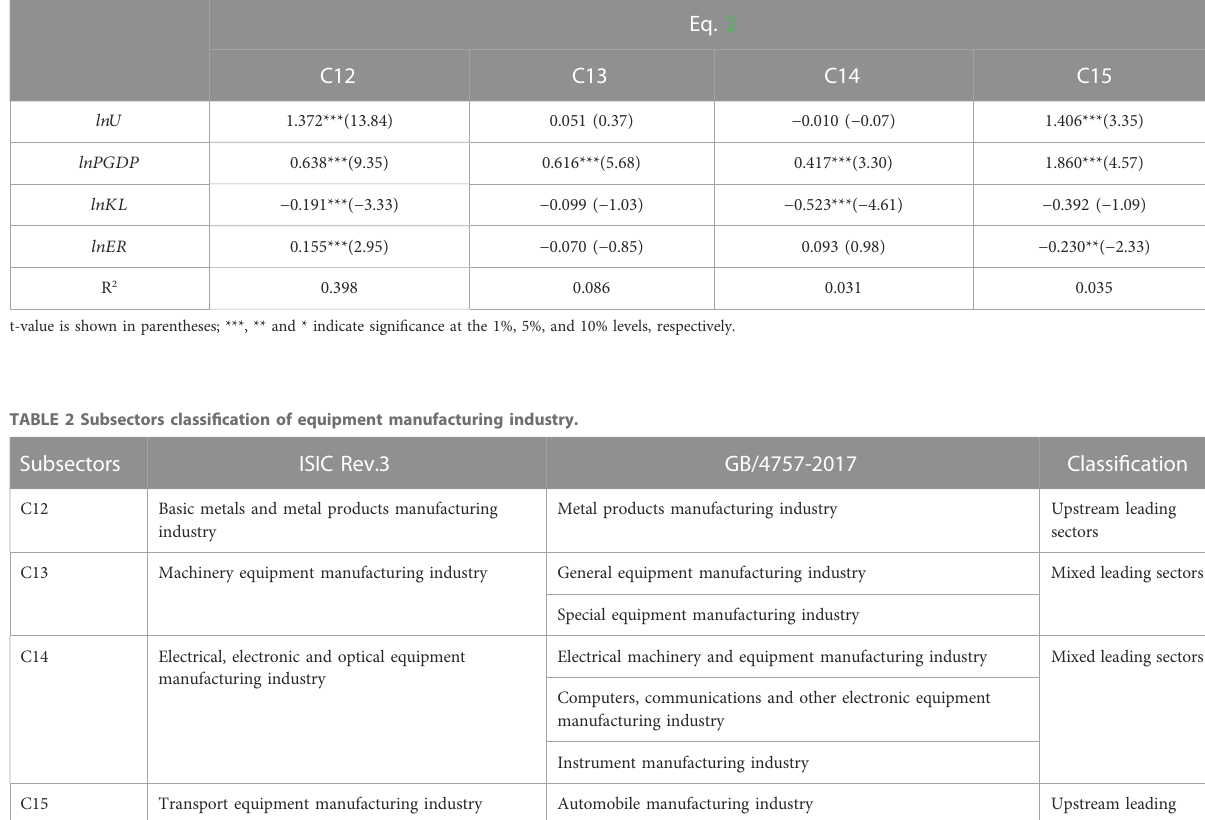
TABLE 1 Regression results of upstream degree and GVC upgrading in subsectors of equipment manufacturing industry.